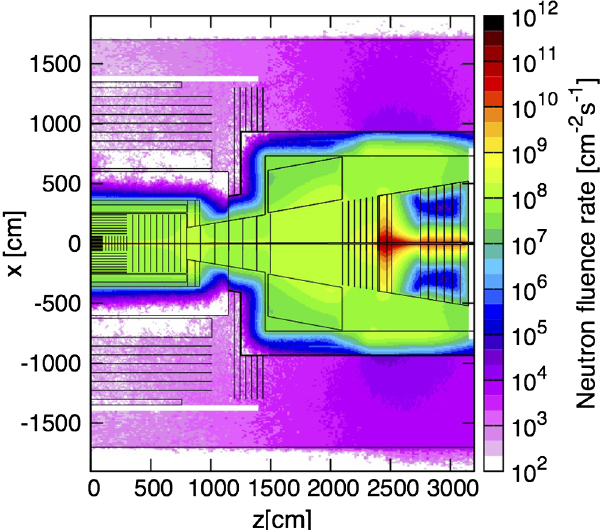
FIG. 13. 1 MeV neutron equivalent fluence as a function of x with (square) and without (triangle) shielding, at different z positions in the detector. The values are obtained with an average in the vertical direction on a bin of 1 cm around y ¼ 0 up to x ¼ 0 . 6 m and on a bin of 10 cm for larger x